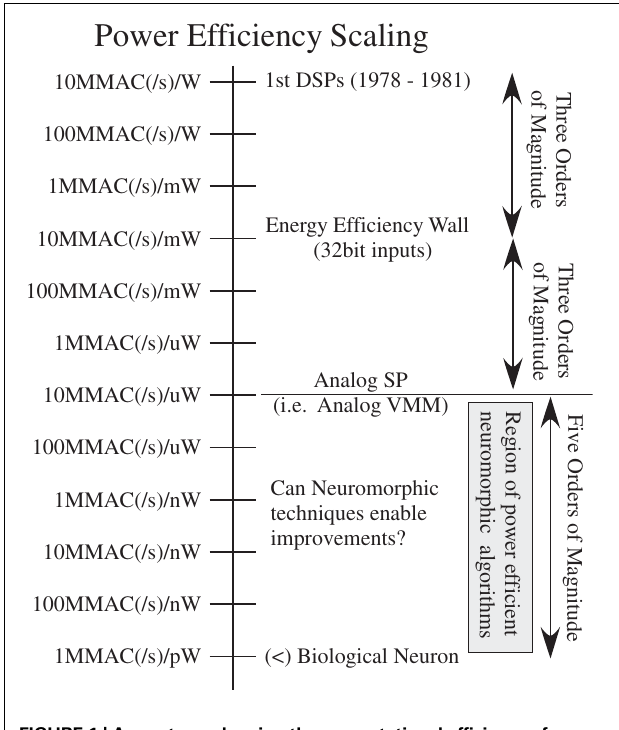
FIGURE 1 | A spectrum showing the computational efficiency of various technologies, including digital technologies, analog Signal Processing (SP), as well as best estimate of biological neuron computation. Three orders of magnitude has produced amazing improvements in digital technology from speak-and-spell devices (Frantz and Wiggins, 1982) to current day smart phones. Three orders of magnitude in analog SP approaches has the promise of similar advancements as it becomes a stable capability. Biological neurons show a potential of five more orders of magnitude of improvement, opening further opportunity for efficient computational devices. Further, this observation defines one definition for efficient neuromorphic systems as those physically implemented algorithms that improve power efficiency beyond the analog SP